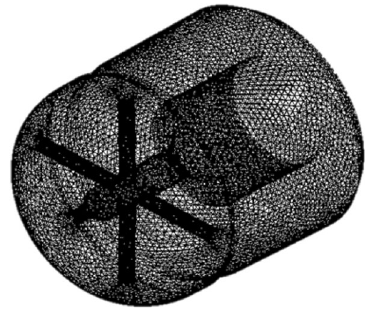
Fig. 4 Meshing of the nozzle design from different cross